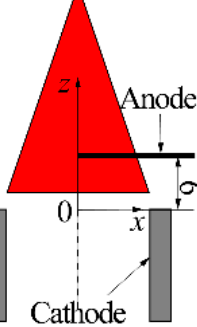
Figure 17. In order to verify the accuracy of the ion current sensor for flame monitoring, an optical flame sensor with an ultraviolet phototube was used to synchronously monitor the flame with the ion current sensor. The signal intensity from the optical sensor could correctly reflect the flame state. The signal intensity of 0 V and 6 V referred to the flame extinction and combustion, respectively.